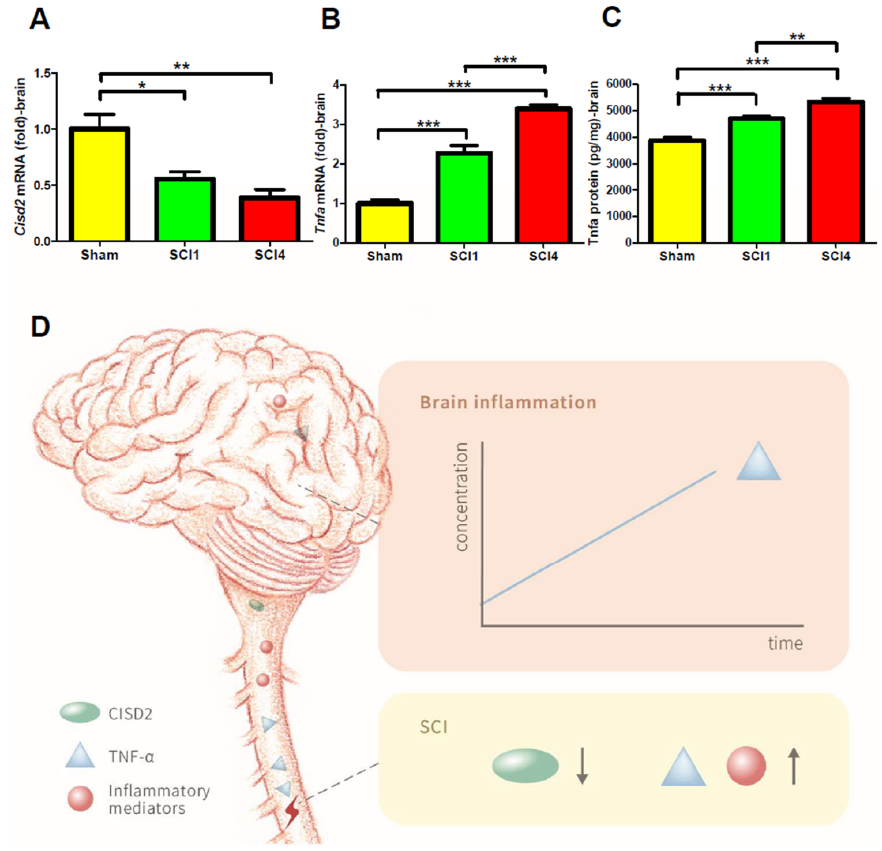
Figure 3. Spinal cord injury (SCI) downregulates Cisd2 and enhances inflammatory response in the brain of mice subjected to spinal cord hemisection. ( A ) The brain levels of Cisd2 mRNA in the 1 and 4 h post-SCI groups were significantly downregulated compared with those in the sham operation group. Additionally, the brain levels of Tnfa mRNA ( B ) and protein ( C ) (detected using enzyme-linked immunosorbent assay [ELISA]) in the 1 and 4 h post-SCI groups were significantly upregulated compared with those in the sham operation group. Vertical bars indicate mean ± standard error of mean of mRNA ( n = 6 for each group) and protein ( n = 6 for each group) levels. * p < 0.05, ** p < 0.01, and *** p < 0.001 (pair-wise multiple comparisons between groups were performed using the Newman–Keuls test). ( D ) Schematic diagrams illustrating the pivotal points in Figures 1 and 2 that are indicative of the vulnerability of the central nervous system (CNS) to inflammation. After SCI, inflammatory mediators delivered through the cerebrospinal fluid (CSF) promote brain inflammation as evidenced by the upregulation of TNFA and inflammatory mediators. The expression of CISD2 is decreased in the injured spinal cord and inflamed brain, which exacerbates inflammation.